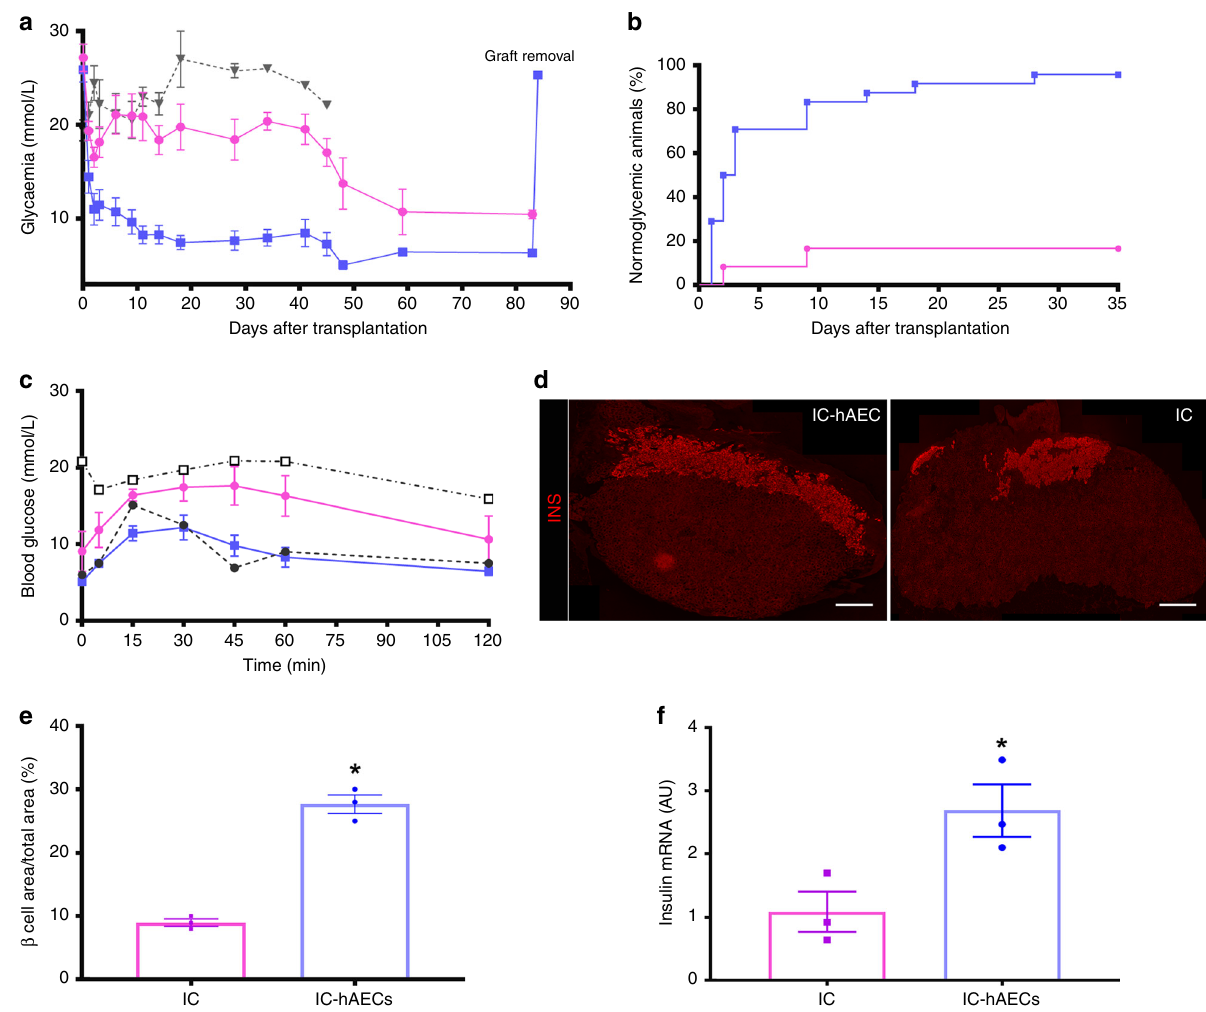
Fig. 4 In vivo function of islet organoids. a Blood glucose measurements. **** p < 0.0001 IC-hAEC (blue squares, n = 25) vs IC (magenta circles, n = 25), * p IC vs, hAEC (gray triangles, n = 5), **** p < 0.0001 IC-hAEC vs hAEC, one-way ANOVA, with Tukey ’ s multiple comparison test. b Percentage of cured mice after islet spheroid transplantation. c . Intraperitoneal glucose tolerance tests. ** p < 0.01 IC-hAEC (blue squares, n = 10) vs IC (magenta circles, n = 10), one-way ANOVA, with Tukey ’ s multiple comparison test. Gray squares diabetic non-transplanted controls, gray circles non- diabetic, non-transplanted controls. d , e Insulin-positive area of each group visualized by the immunostaining and its percentage per given area 4 months after transplantation. **** p < 0.0003, unpaired Student ’ s t test, n = 3. Scale bars = 500 μ m. f Rat insulin mRNA levels in retrieved grafts after marginal islet spheroid